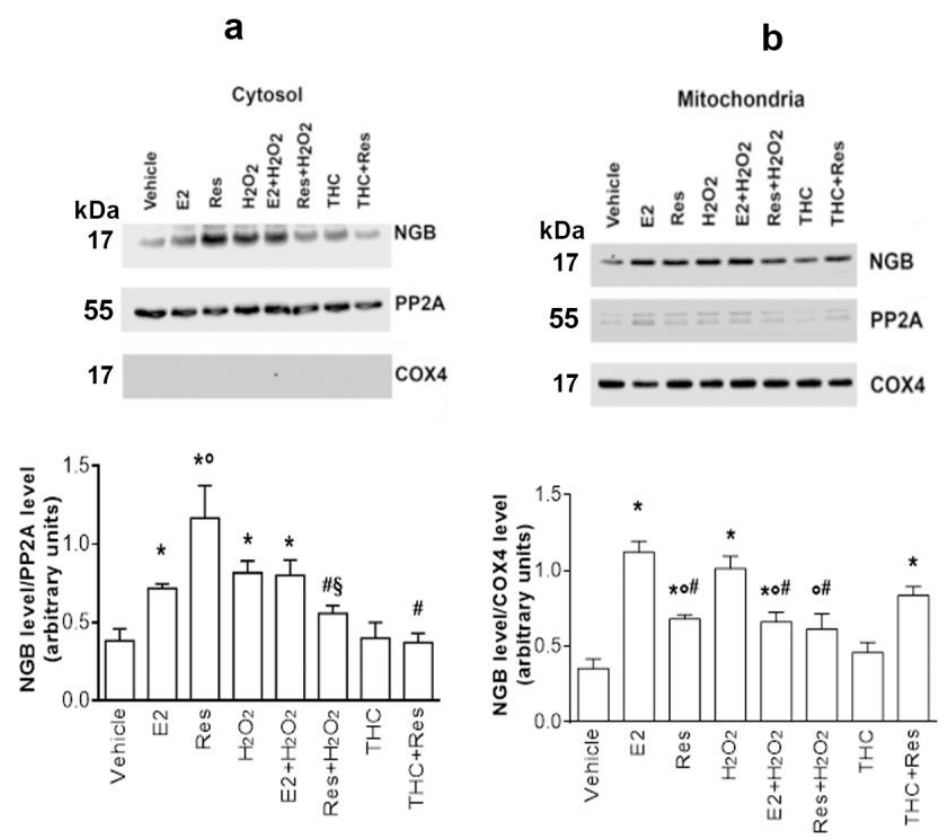
Figure 4. Effect of Res on NGB localization. ( a ) Western blot analysis of NGB levels in SH-SY5Y cytosolic portion, treated with vehicle (DMSO 1:1000, v : v ), E2 (10 − 9 M), Res (10 − 7 M), H 2 O 2 (5 × 10 − 5 M), and E2 + H 2 O 2 , Res + H 2 O 2 and (R,R)-THC + Res treatments at the same concentrations; (R,R)-THC (10 − 6 M) was administrated 1 h before the other treatments (24 h). PP2A and COX4 protein levels were used to confirm the purity of the isolated compartments (cytosol and mitochondria, respectively). The upper panel shows a Western blot type, and the lower panel shows the densitometric analysis of at least three different experiments. Data are reported as mean ± SD. p < 0.01 was calculated with Student’s t -test with respect to vehicle (*), E2 ( ◦ ) or Res (#), or H 2 O 2 (§). ( b ) Western blot analysis of NGB levels in the mitochondrial fraction in SH-SY5Y cells, treated as reported in panel a. The upper panel shows a Western blot type, and the lower panel shows the densitometric analysis of at least three different experiments. Data are reported as mean ± SD. p < 0.01 was calculated with Student’s t -test with respect to vehicle (*), E2 ( ◦ ), and H 2 O 2 (#). The NGB level in mitochondria was also confirmed with confocal microscopy, evaluating NGB colocalization (red) with the mitochondrial protein COX4 (green) (Figure 5). Differently from what is reported in Figure 4b, the results indicate that either E2, Res, and H 2 O 2 increase NGB levels in the mitochondria to the same extent (see bottom